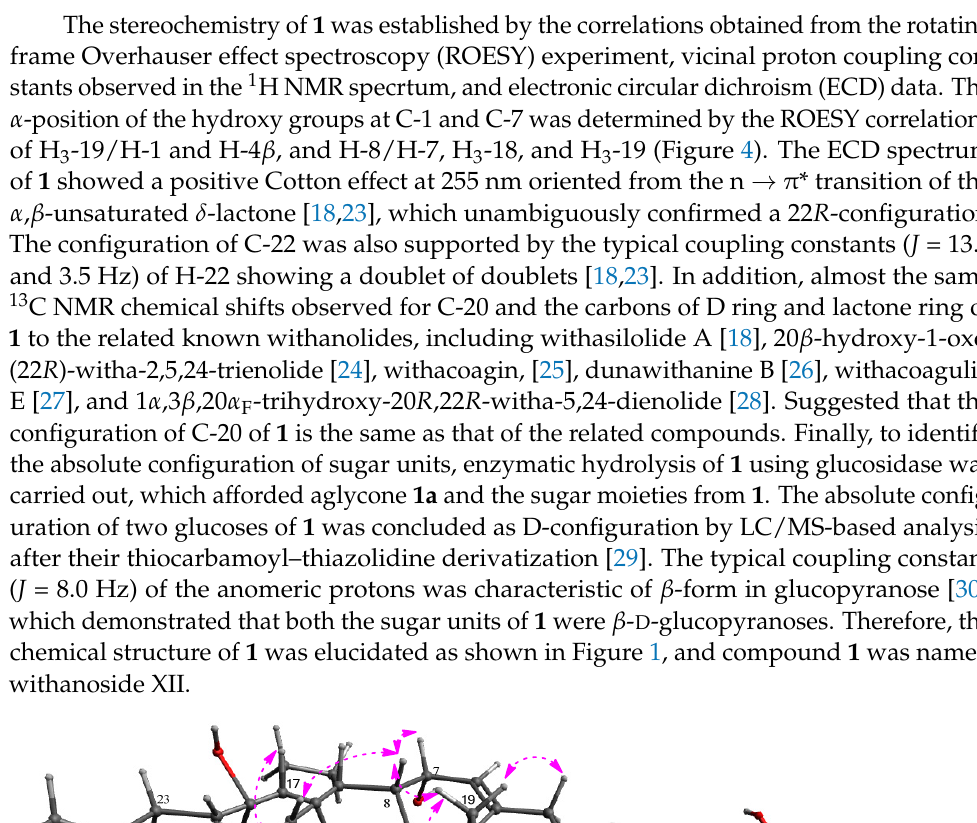
Figure 5. Key 1 H- 1 H COSY ( ) and HMBC ( ) correlations for 1a .